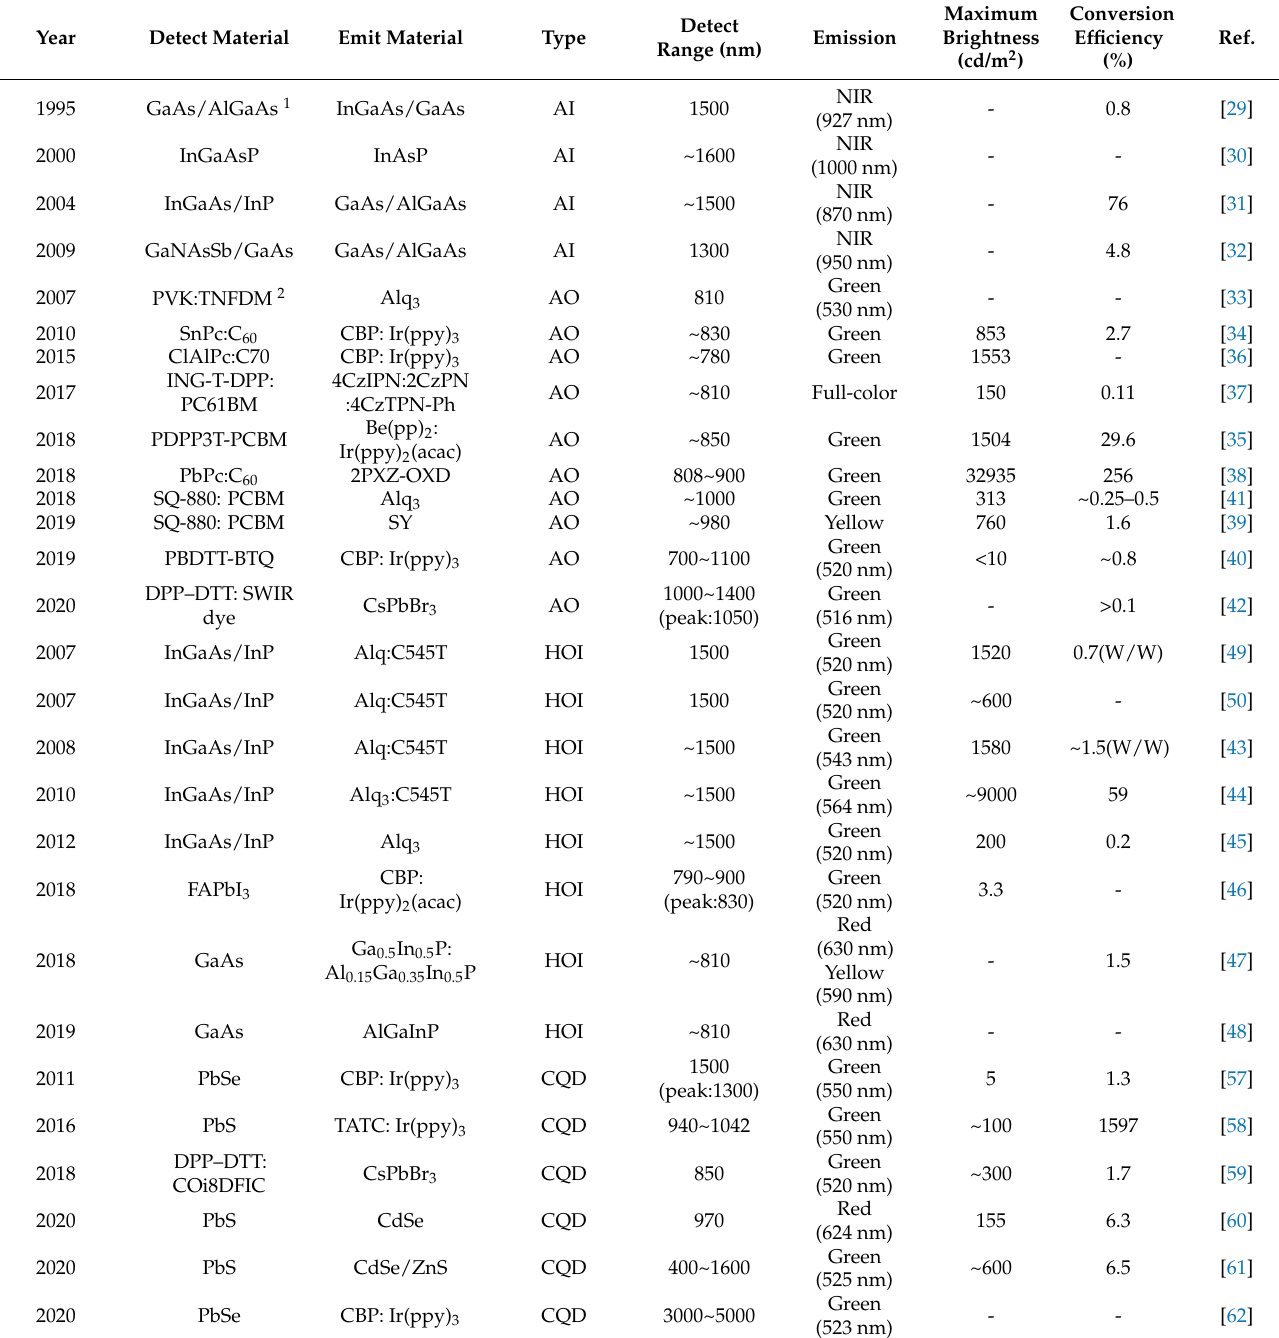
Table 1. Progress in upconversion